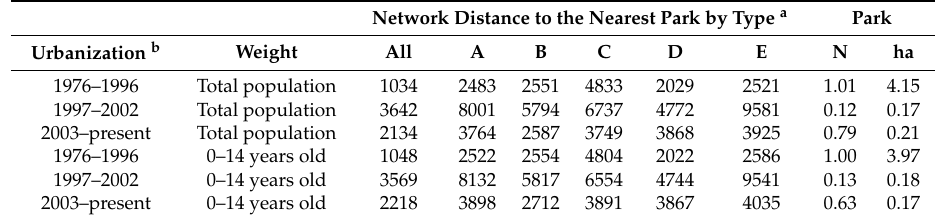
Table 7. Means of accessibility measures for wards according to the three periods of urbanization. Network Distance to the Nearest Park by Type